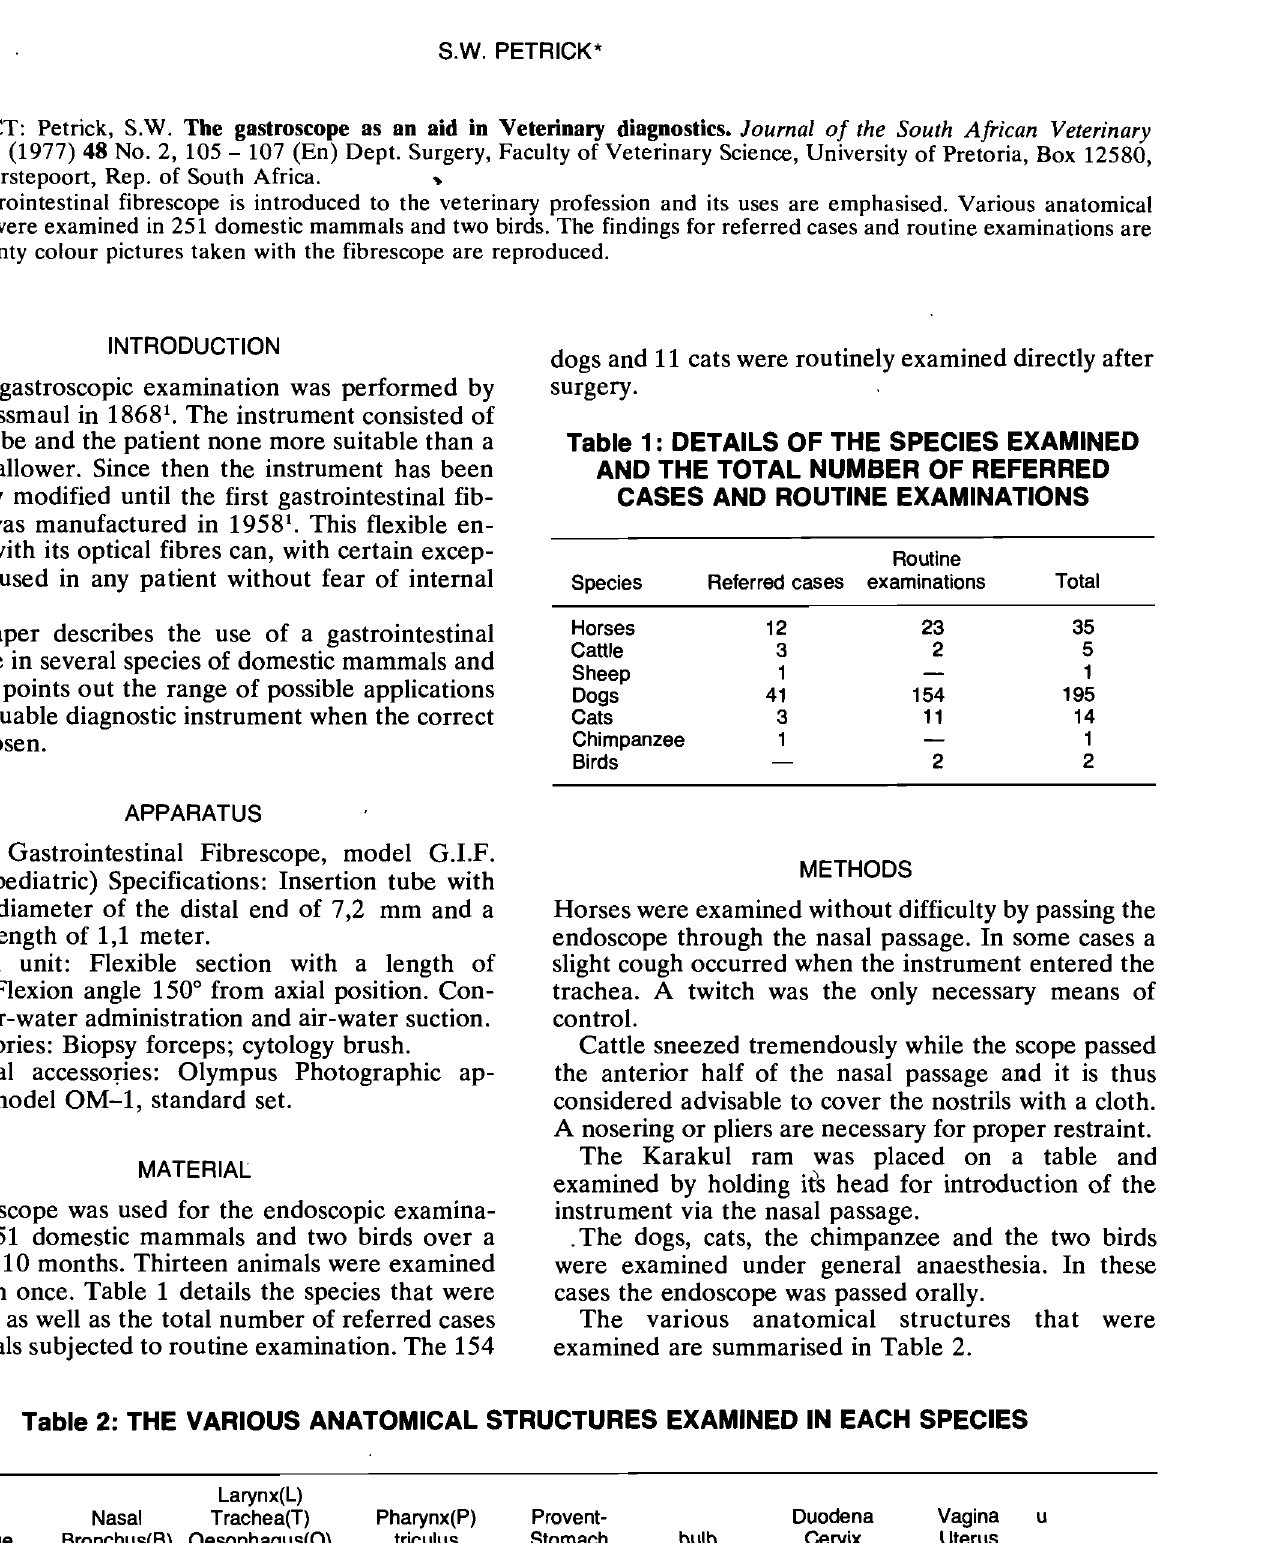
Species passage Horses Cattle Sheep